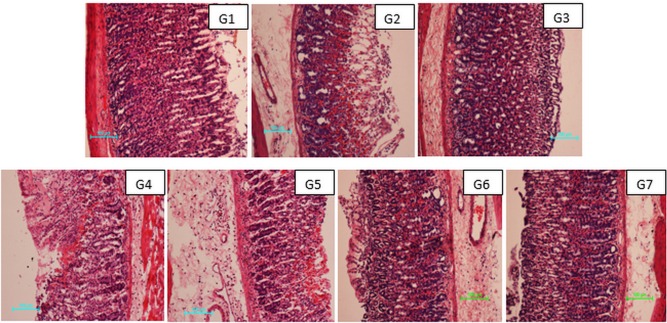
Effects of V. pubescens on the histology of the stomach wall in ethanol-induced gastric mucosal damage in rats.(G1) (Normal control group); (G2) (Ulcer control group); (G3) (Omeprazole); (G4) (62.5 mg/kg), (G5) (125 mg/kg), (G6) (250 mg/kg) and (G7) (500 mg/kg) of V. pubescens extract. There were 6 rats in each group of experiment. The rats in the experimental groups (groups 4–7) exhibited markedly better protection of the gastric mucosa, as shown by the reduced ulcer area (white arrow), submucosal edema and leucocyte infiltration (blue arrow) of the submucosal layer (H&E staining magnification 10×).